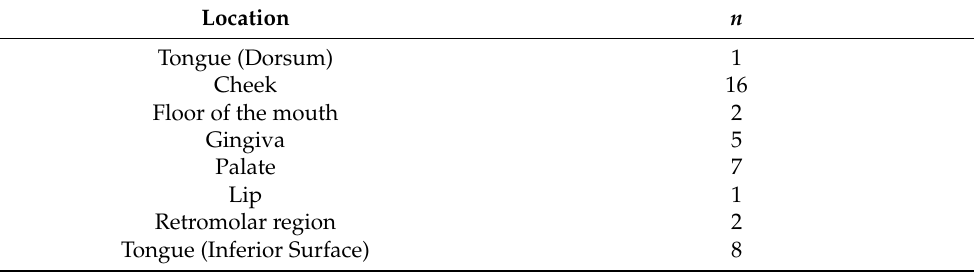
Table 2. Location of biopsied lesions ( n = 42).